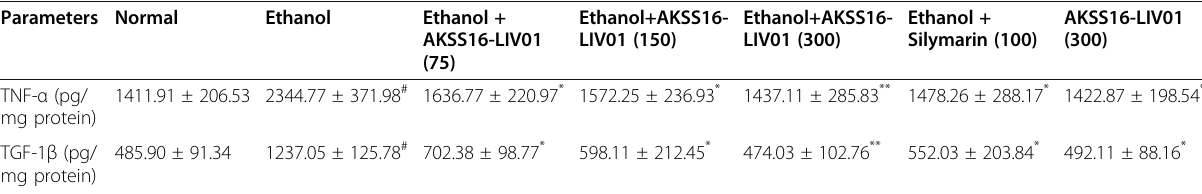
Table 9 Effect of AKSS16-LIV01 on TNF α and TGF 1 β levels in liver tissue in chronic ethanol-induced hepatic damage in mice Parameters